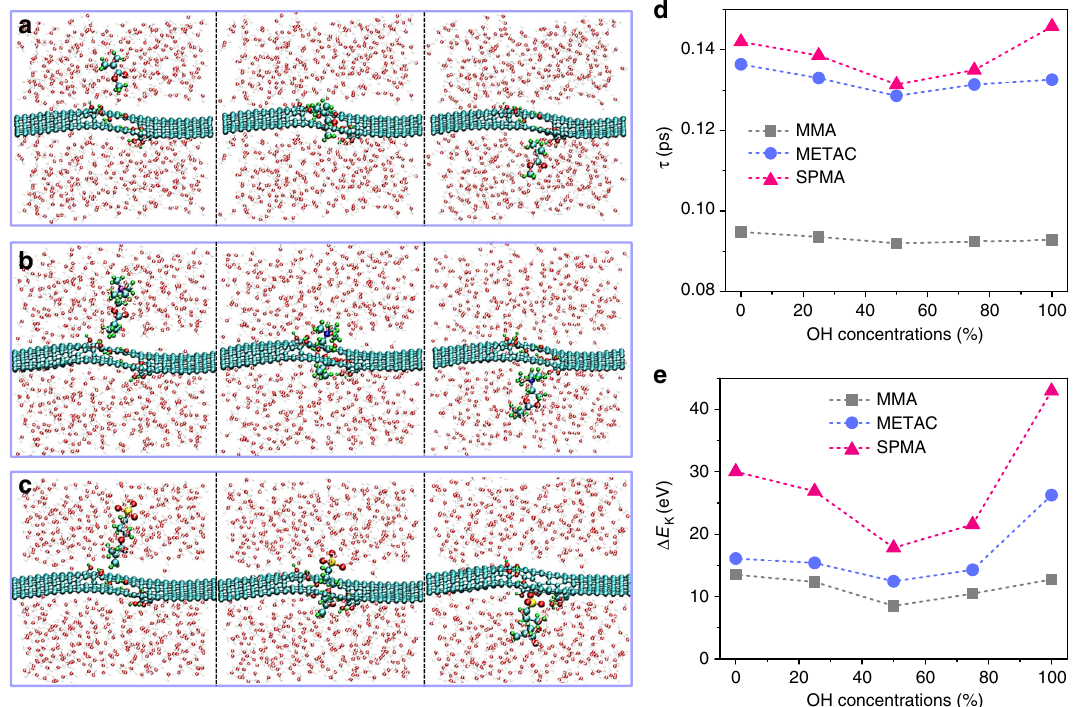
Fig. 5 Simulation of monomers translocation through graphene defects. The snapshots of different monomers translocation through a graphene defect passivated with OH termination, a MMA, b METAC and c SPMA. Variation of the d translocation time τ and e the kinetic energy change Δ E K as a function of the OH concentration for the monomers in the initially CH 3 -passivated nanopore. Δ E K = E K,bef − E K,aft , with E K,bef and E K,aft as the kinetic energy of the monomer before and after the translocation process,